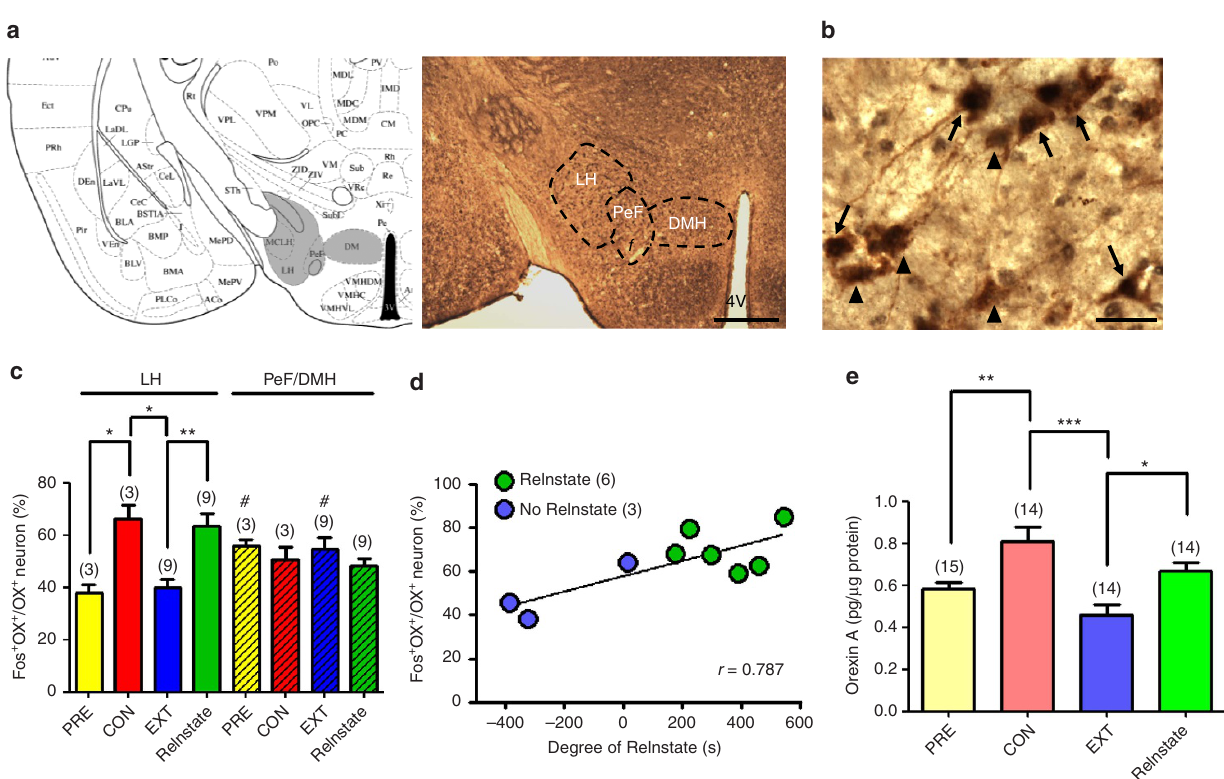
Figure 7 | Restraint stress increased the number of c-fos-expressing orexin neurons in the LH and orexin A levels in the VTA. ( a , b ) A representative hypothalamic section taken at the level of ( a ) the LH and PeF/DMH or ( b ) the LH (reproduced from ref. 52) from a pre-conditioned mouse. Scale bars: ( a ) 300 m m, ( b ) 20 m m. Orexin A (OX þ ) was labelled by DAB (ref. 18) and c-fos (Fos þ ) was labelled by DAB with nickel (black in nucleus). Arrows indicate neurons doubly immunoreactive for orexin A and c-fos (Fos þ OX þ ). Arrowheads indicate orexin neurons without c-fos staining. 4V: the fourth ventricle. ( c ) The number of Fos þ OX þ neurons as a percentage of total OX þ neurons, which reflects the percentage of activated orexin neurons, in the LH or PeF/DMH at each stage (PRE: n ¼ 3; CON: n ¼ 3; extinction: n ¼ 9; reinstatement: n ¼ 9, * P o 0.05; ** P o 0.01, one-way ANOVA with Newman–Keuls post hoc test; # P o 0.05, paired t -test). ( d ) The association between the number of activated LH orexin neurons and the degree of reinstatement, expressed by the CPP score difference between reinstatement and extinction stages. Note that there is a positive linear correlation between the number of activated orexin neurons and the degree of reinstatement of cocaine CPP in mice whether (green dots) or not (blue dots) restraint stress reinstated cocaine CPP. n ¼ 9, r ¼ 0.787, P o 0.05. ( e ) The average level of orexin A in the VTA homogenate at each stage of cocaine CPP. (PRE: n ¼ 15; CON: n ¼ 14;